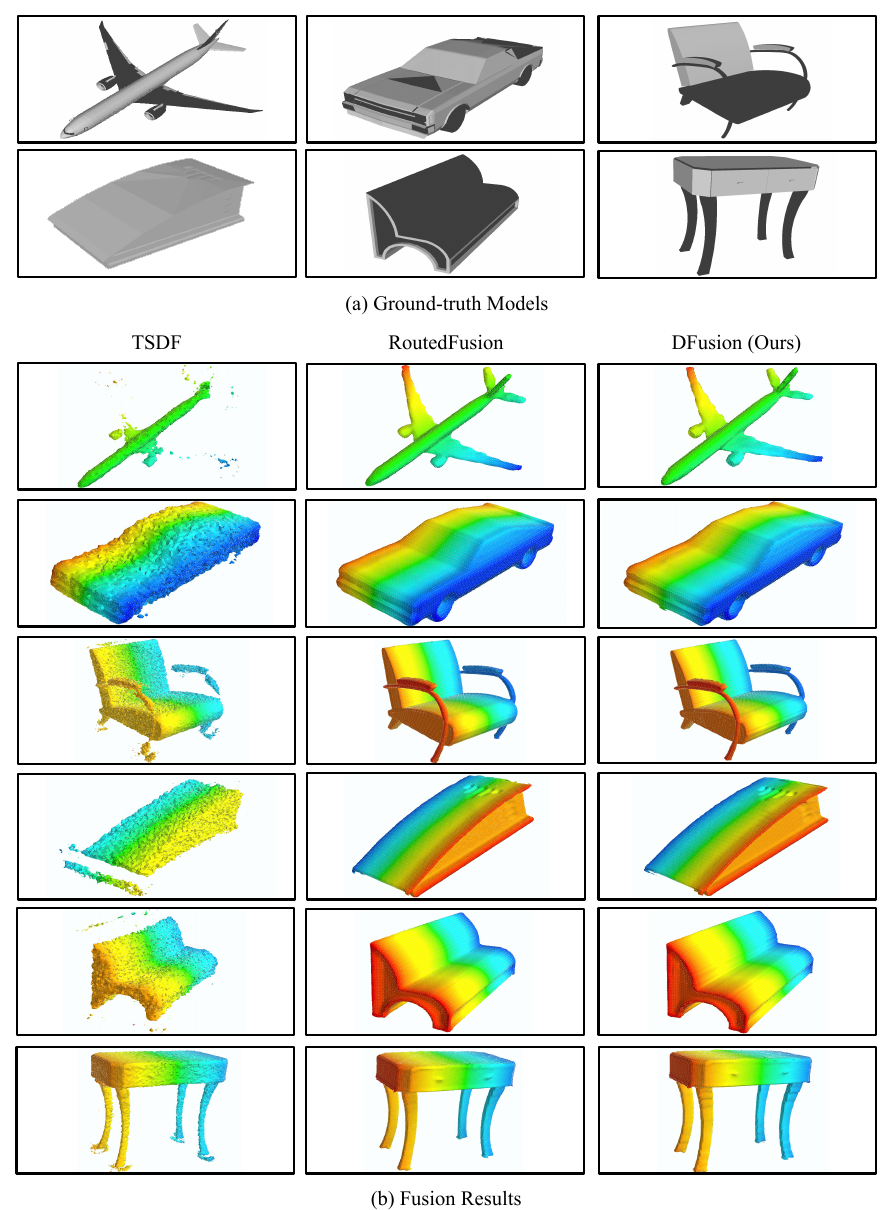
Figure 5. Fusion results on the ShapeNet dataset with depth noise